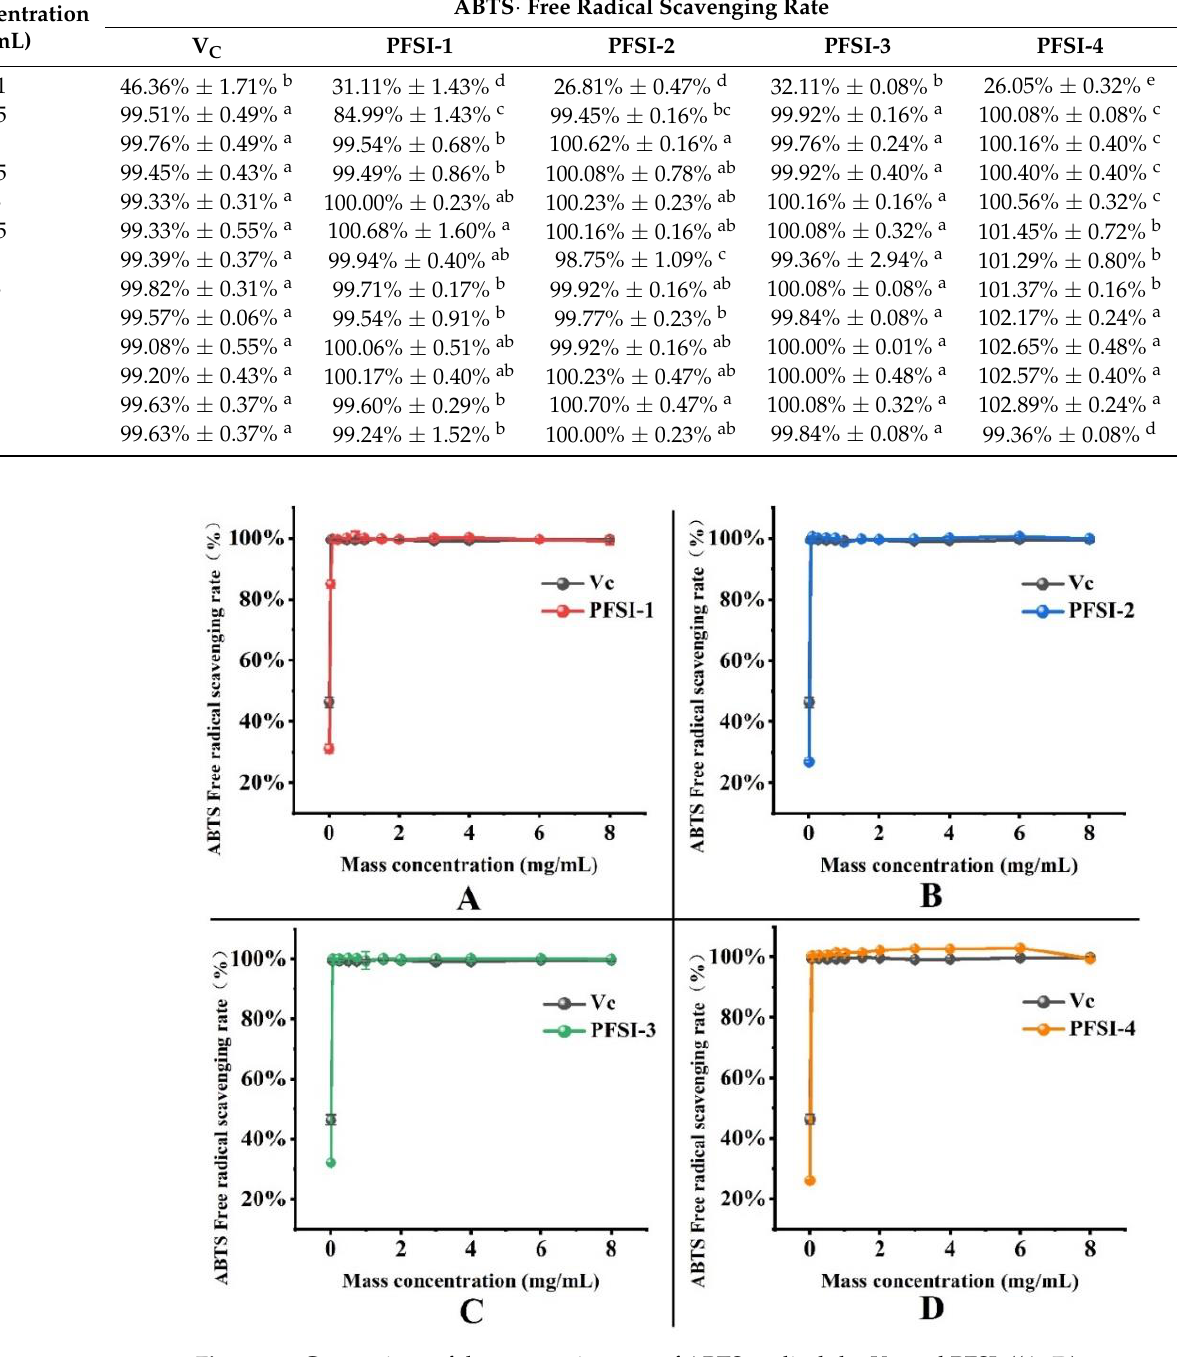
maximum FRAP/When the concentration reached 8 mg/mL, PFSI-1 reached the